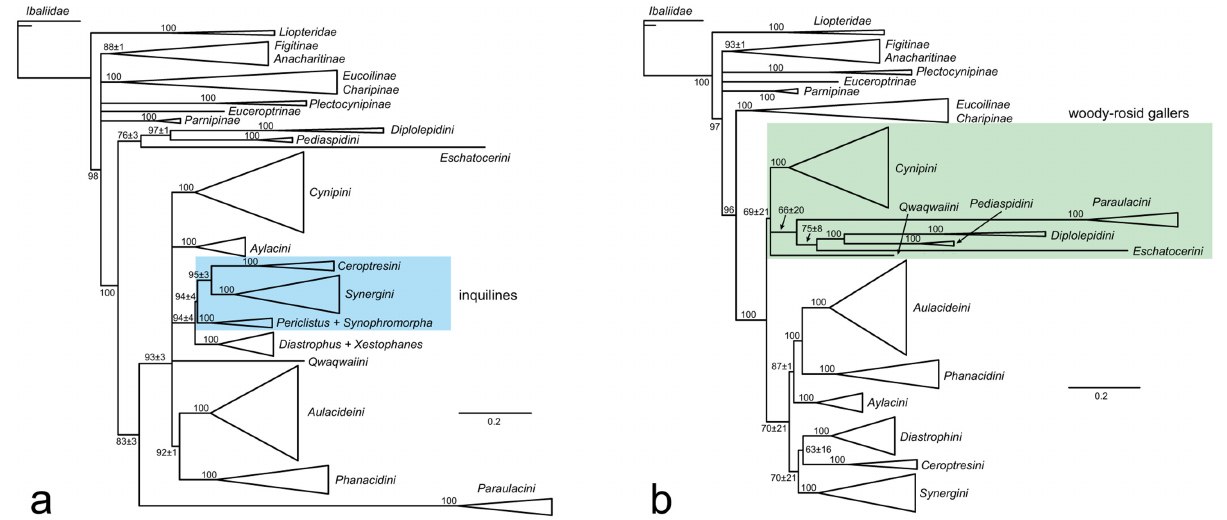
Fig 5. Constrained analyses. Results from analyses in which (a) the inquilines were constrained to be monophyletic or (b) the woody-rosid gallers were constrained to be monophyletic. In both cases, Paraulacini was allowed to ‘ float ’ , that is, it was allowed to be placed either inside or outside the constrained